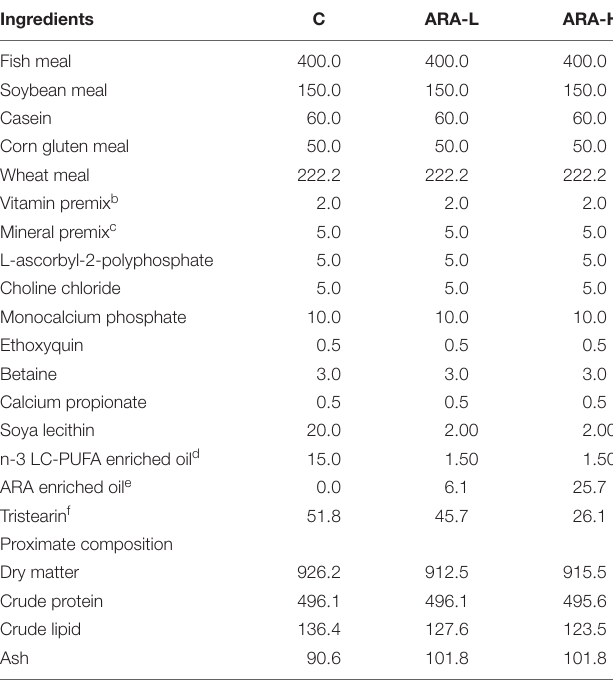
TABLE 1 | Formulation and composition of the experimental diets (g kg − 1 dry matter) a .